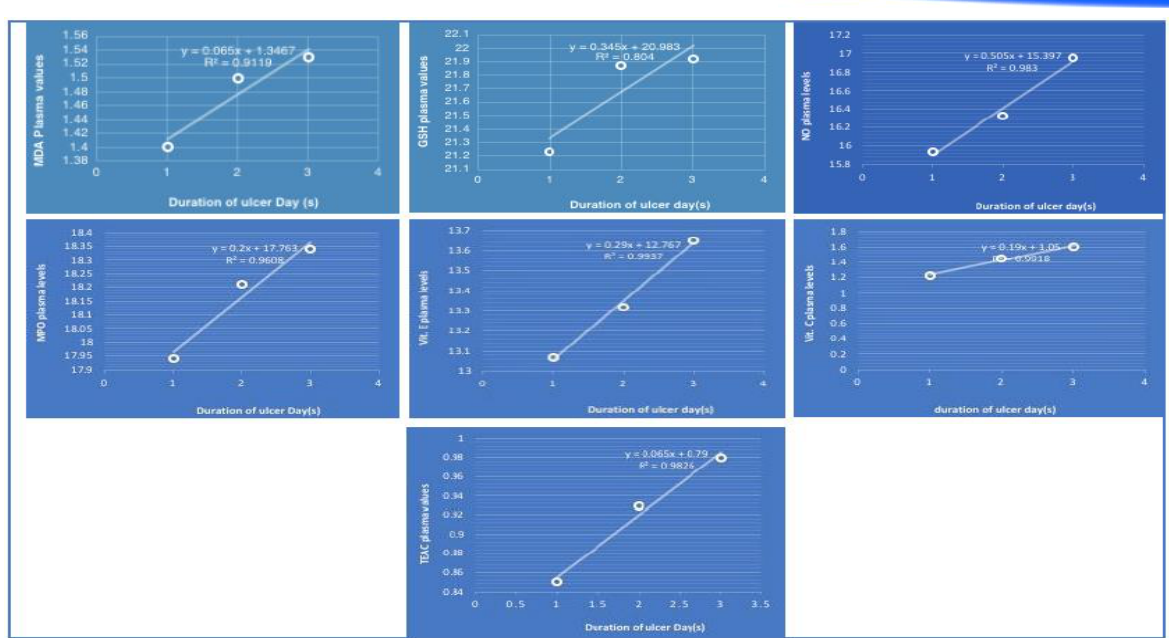
Figure 4: Plasma antioxidant positive correlation with the duration of current ulcer in the tested groups. MDA: malondialdehyde; GSH: glutathione; NO: nitric oxide; MPO: myeloperoxidase; Vit. E: Vit. E, Vit. C: Vit. C, Trolox equivalent antioxidant capacity: TEAC.